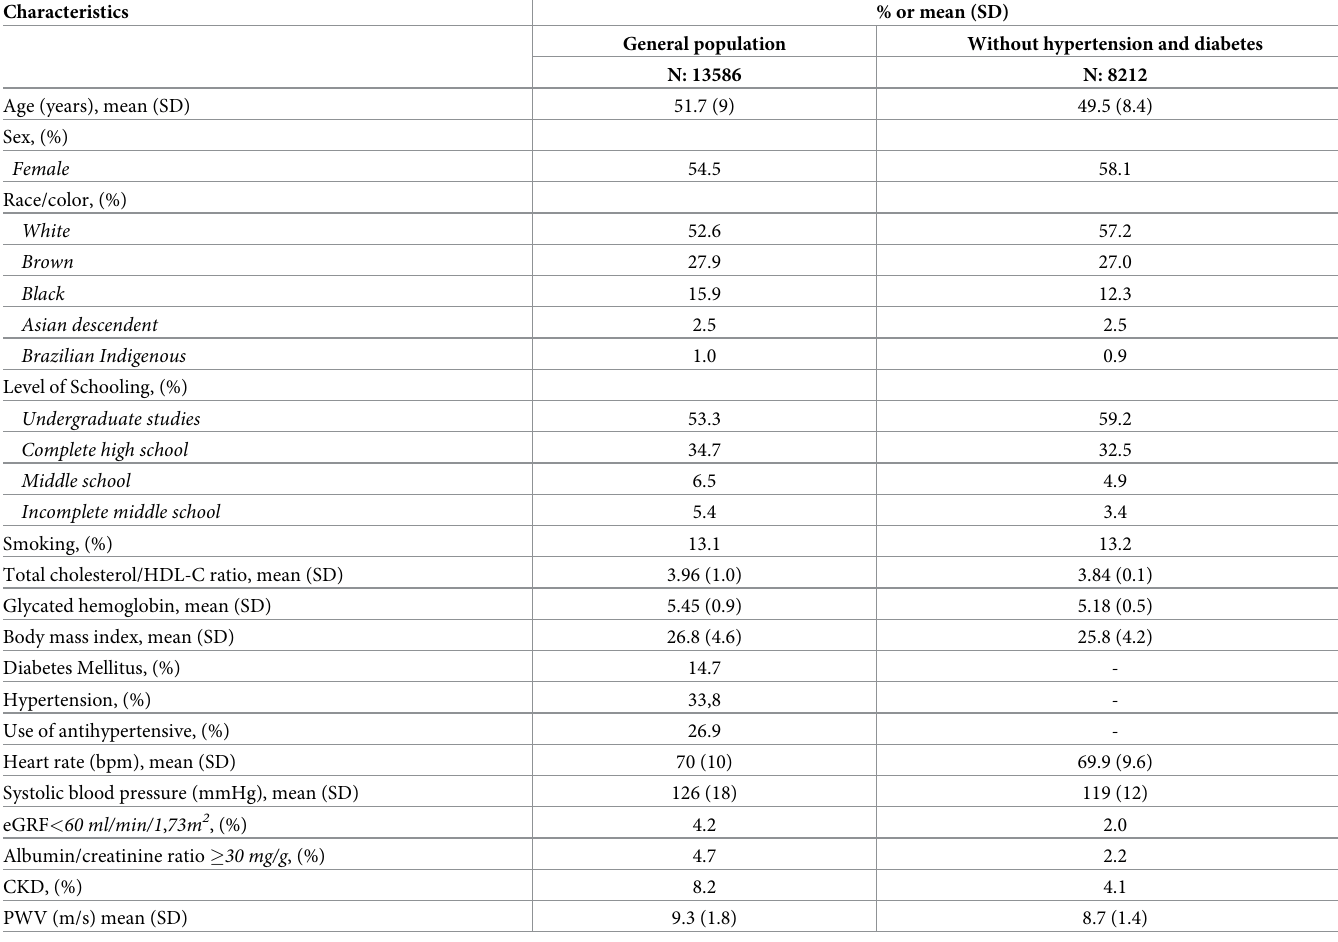
Table 1. Descriptive characteristics of participants from baseline of the Brazilian longitudinal study of adult health (ELSA-Brasil), 2008–2010, (N = 13586). Characteristics % or mean